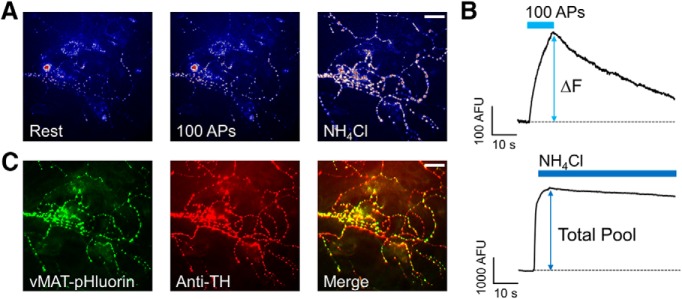

Measurement of SV exocytosis in dopaminergic neurons. A, Representative fluorescence images of a cultured VTA neuron transfected with vMAT2-pHluorin at rest (left), after stimulation with a train of 100 APs delivered at 10 Hz (middle), and after perfusion with 50 mM NH4Cl in Tyrode’s solution (with an equivalent reduction in NaCl) to alkalinize the SV interior (right). Scale bar, 10 μm. B, Representative traces of fluorescence responses to 100 APs at 10 Hz after 5 s of baseline fluorescence values (top), and to perfusion with 50 mM NH4Cl (bottom). Vertical arrow represents the change in fluorescence (ΔF). Blue bars indicate electrical stimulation (top) or NH4Cl perfusion that defines the TP (bottom). C, Fluorescence images of a neuron transfected with vMAT2-pHluorin (green, left) and stained post hoc with anti-TH (red, middle). Composite image shows overlap of vMAT2-pHluorin and TH indicating this neuron is dopaminergic (right). Scale bar, 10 μm.